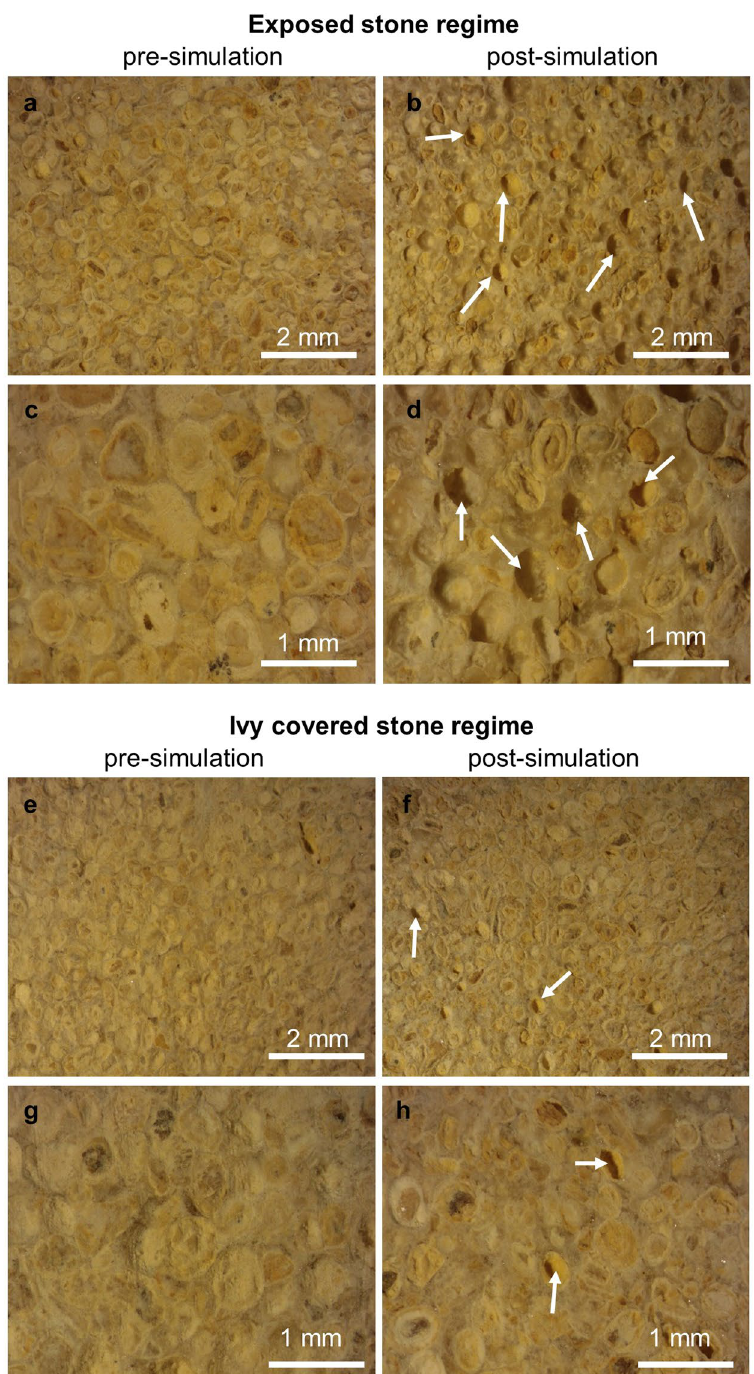
Figure 4. Indicative microscope images of Elm Park Limestone before and after frost weathering simulations for ‘exposed stone’ ( a - d ) and ‘ivy covered’ regimes ( e - f ). Two magnifications, scale as shown. Areas of ooid loss are